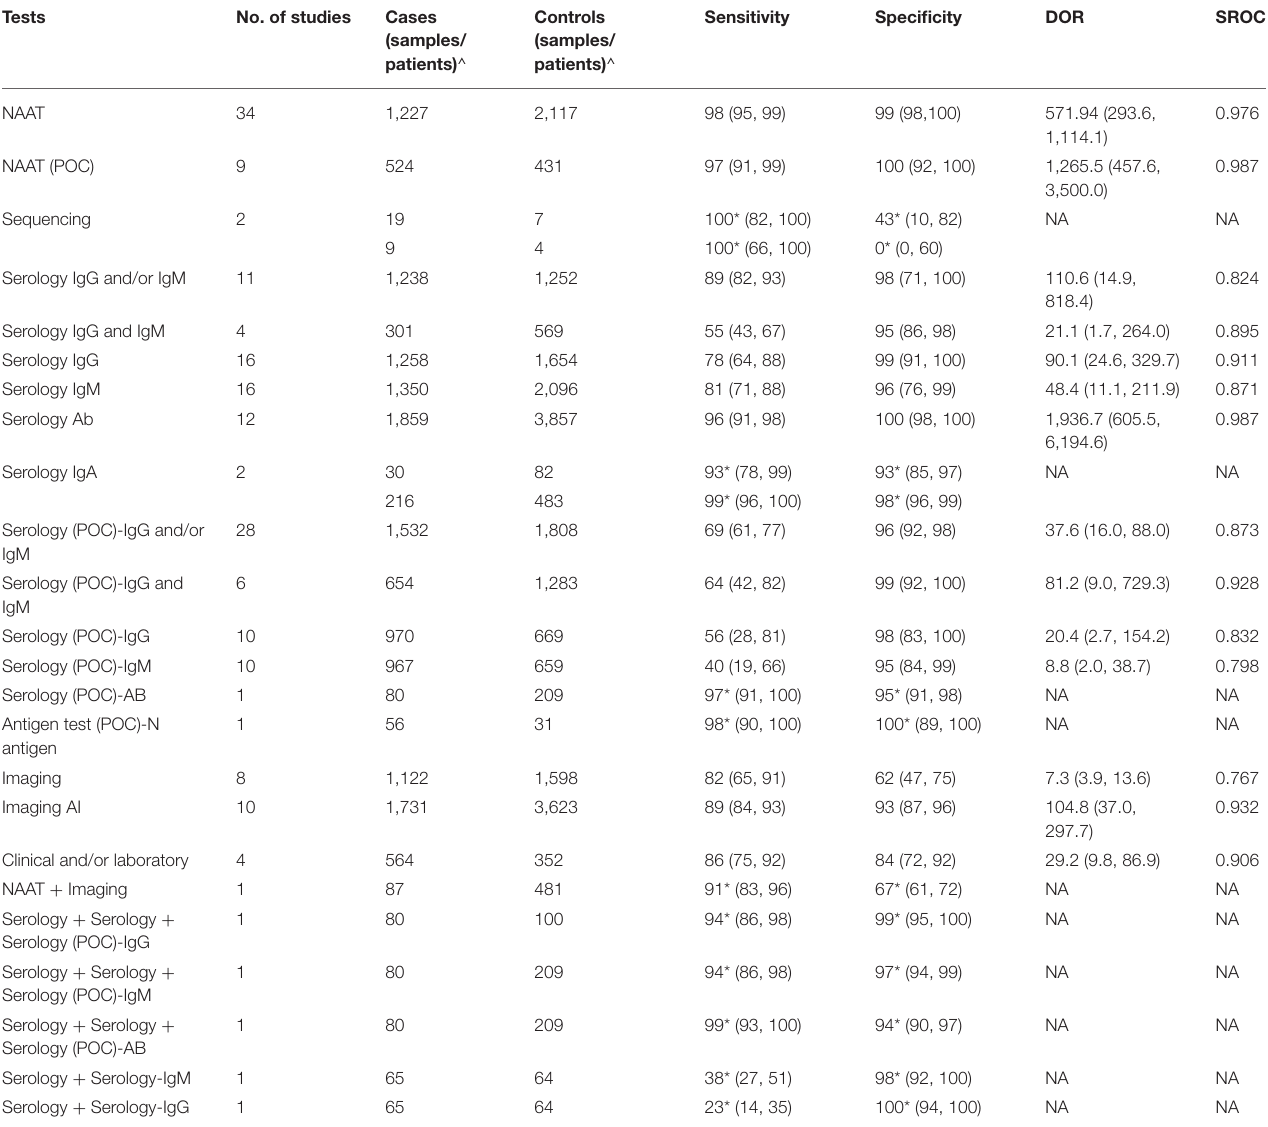
TABLE 1 | Pooled estimates for the different diagnostic